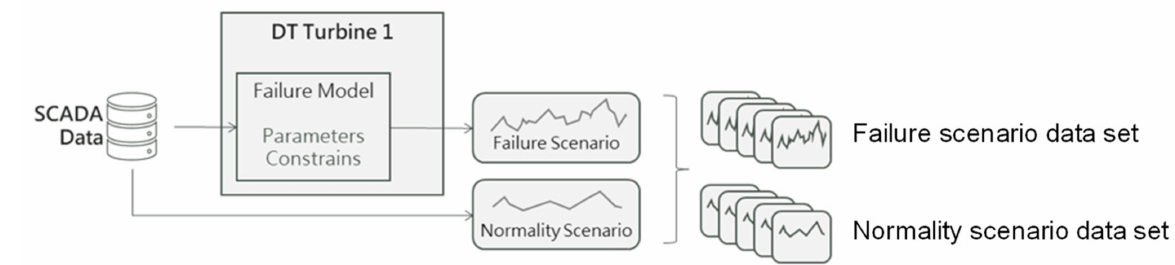
Figure 6. DT generative failure models.